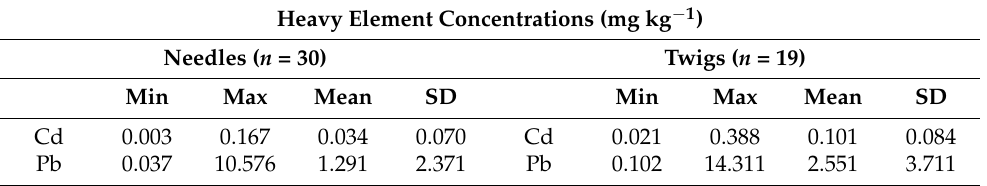
Table 1. Concentrations of heavy metals in needles and twigs ( n =